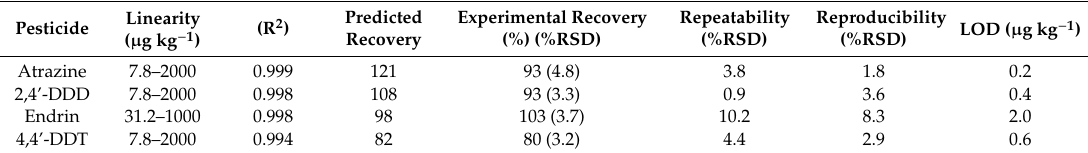
Table 3. Analytical performances of the proposed SFE method with GC-MS analysis for onion samples spiked with atrazine, 2,4’-DDD, endrin, and 4,4’-DDT.